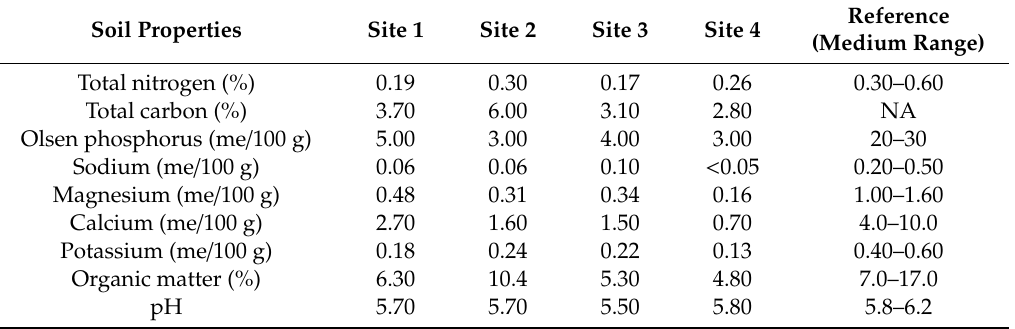
Table 1. Comparison of soil properties between experimental sites. The medium or optimum range guidelines relate to Hills’ laboratories’ crop guides for mixed